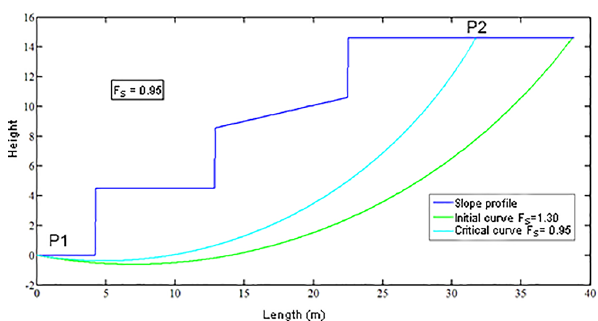
Figure 4. Outcome of the TS model after the introduction of the in- filtration factor, producing an unstable circular failure ( F s = 0 .